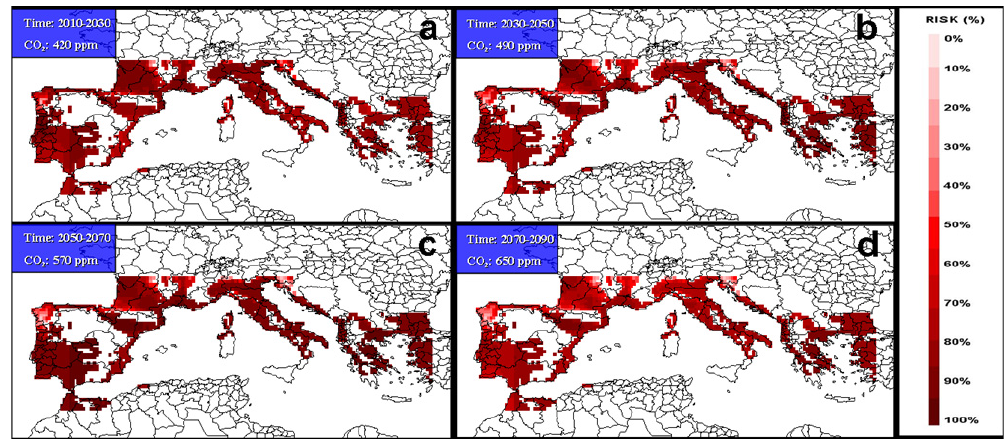
Fig. 4. Spatial plots of risk of durum wheat yield shortfall by: (a) 2010–2030, (b) 2030–2050, (c) 2050–2070 and (d) 2070–2090. The risk was calculated as the relative frequency of future projected yields that do not overcome the selected threshold (30-year mean yield estimated from the